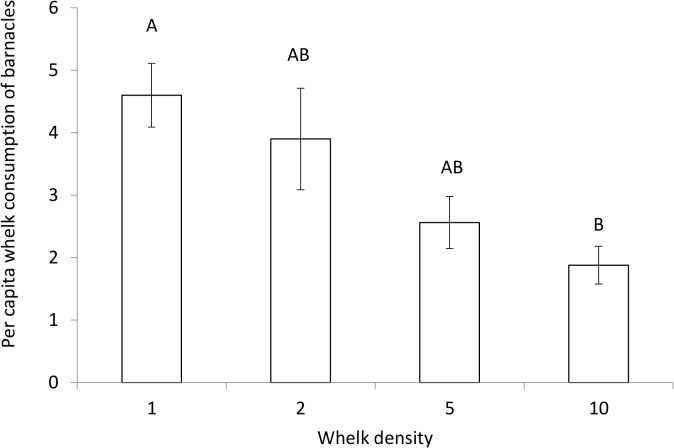
Effects of whelk conspecific density on whelk consumption rates.Mean (±SEM) per capita whelk consumption of barnacles in 1, 2, 5, and 10 whelk density treatments (n = 5) after seven days. Different letters indicate significantly different groups (Tukey HSD tests, p < 0.05).